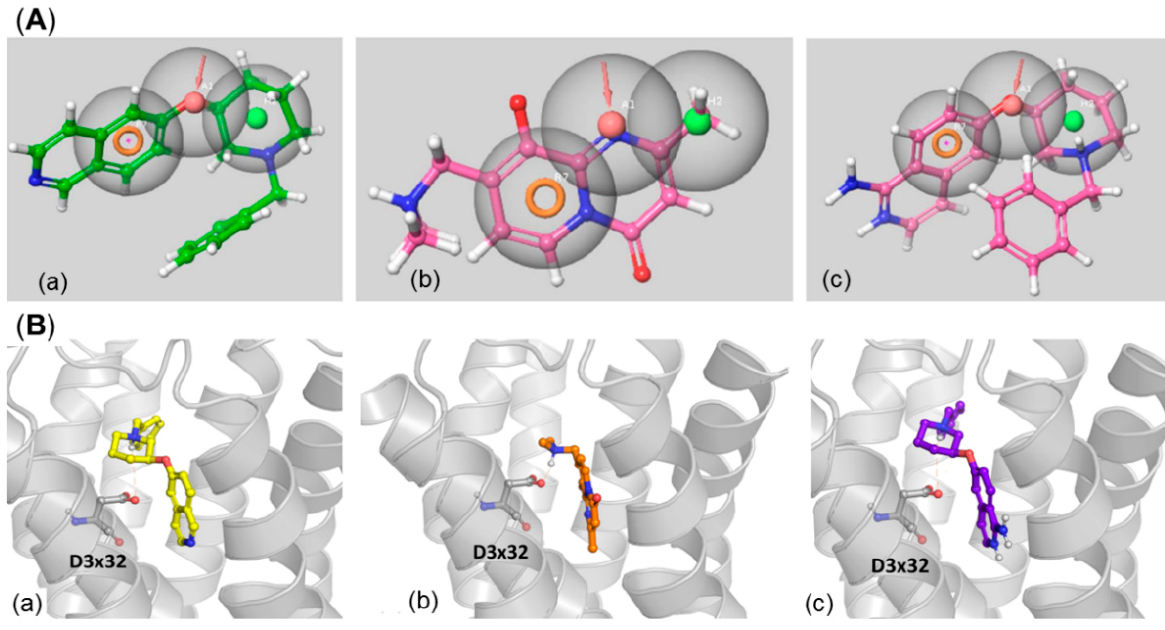
Figure 12. Examples of ROCK I/ROCK II ligands: ( A ) mapped to the 5-HT 6 R pharmacophore model; ( B ) docked to homology model of 5-HT 6 R; ( a ) 31 , ( b ) 44 , ( c ) 32 .